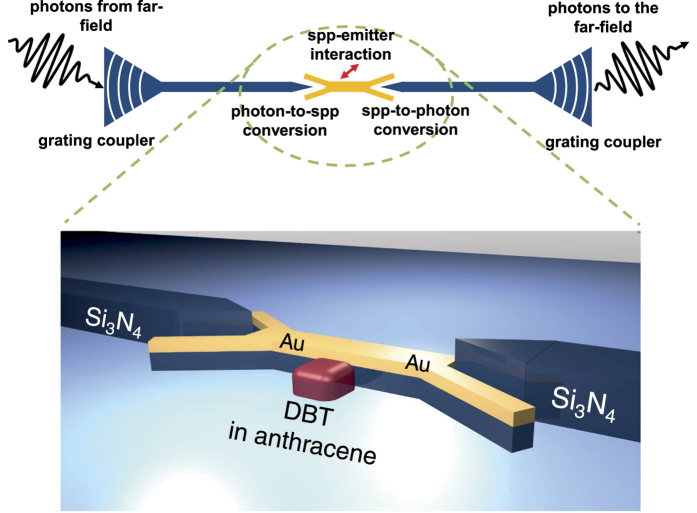
Scheme of a single photon non-linear device.A stream of photons is coupled via a dielectric grating coupler to a dielectric waveguide made from Si3N4 (blue color) which guides the photons to a V-shaped photon-to-plasmon transducer, where SPPs in a short plasmonic gold stripe waveguide (golden color) are excited. Well aligned emitters (e.g., DBT molecules in AC) experiencing high Purcell factors in the near-field of the plasmonic waveguide, intensely interact with the SPPs. After the interaction, SPPs are transduced back to photons and guided away by a second dielectric waveguide. These photons are eventually coupled out through a second grating coupler.